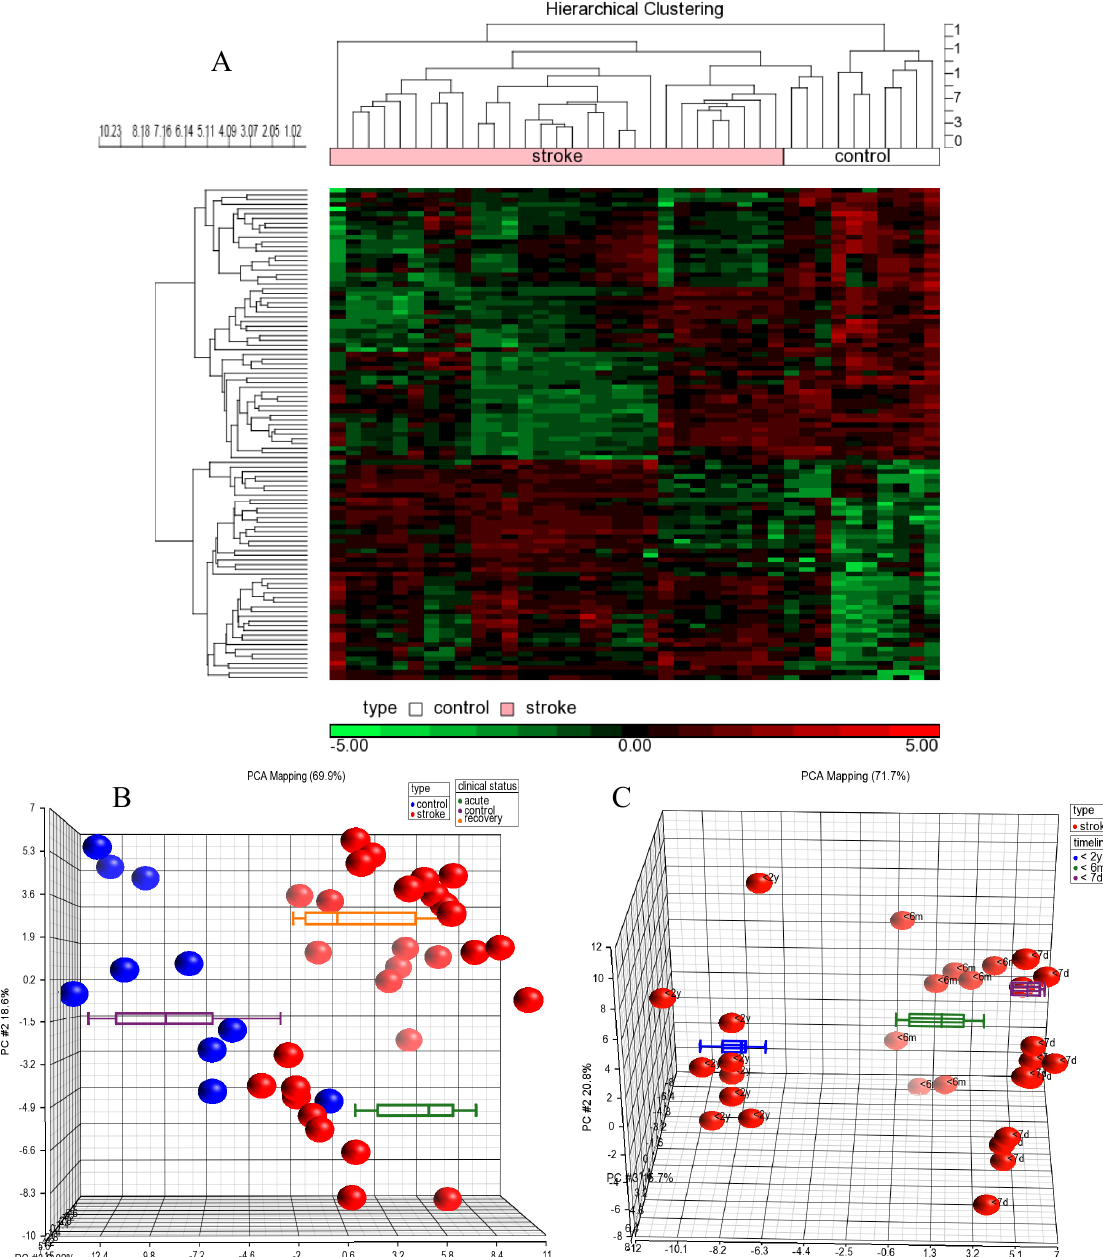
Figure 1. Cluster plots of miRNA profiles. ( A ) Hierarchical clustering of miRNA profiles. miRNA profiling data showed that control samples were clustered away from stroke patients. The upregulated miRNAs are shown in red and downregulated miRNAs are shown in green; ( B ) Principal Component Analysis (PCA) and Box-whisker plots. PCA analysis showed segregation of controls (blue circles) away from stroke (red circles) patients. Box-whisker plots showed that the samples segregated into three absolute categories; healthy controls (purple box-whiskers), acute stroke (green box-whiskers) and “recovered” stroke patients (orange box-whiskers); and ( C ) PCA plots with time-based segregation. Clustering of stroke samples reflected temporal evolution of miRNAs in stroke patients (purple box-whiskers < 7 days; green box-whiskers < 6 months; blue box-whiskers < 24